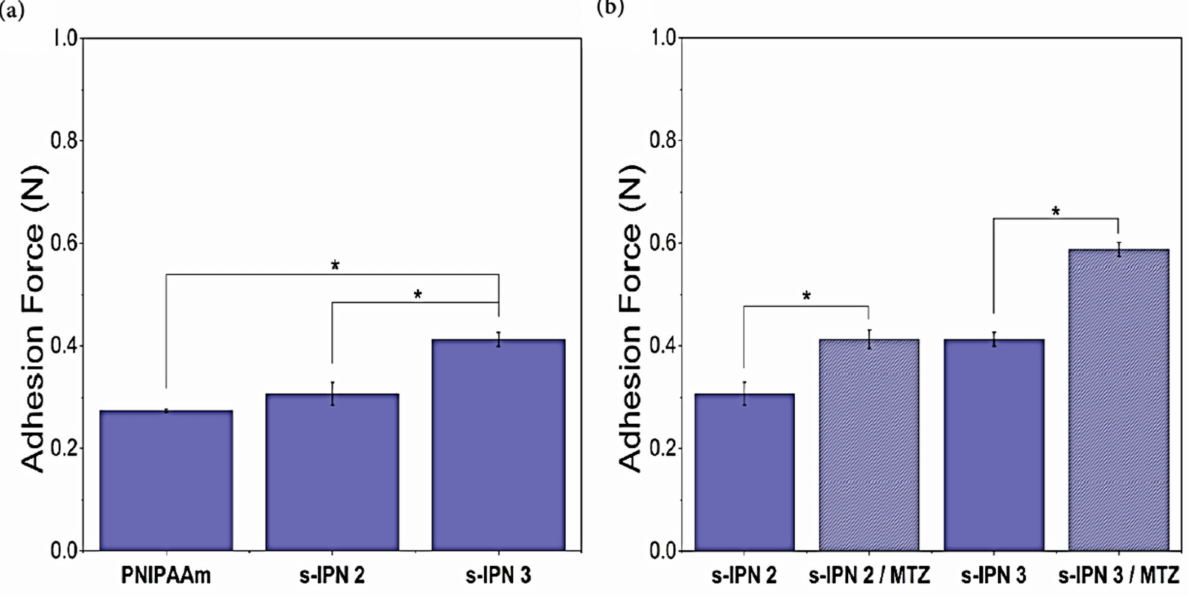
Figure 8. Bioadhesive properties of PNIPAAm, s-IPN 2, and s-IPN 3 samples ( a ), and those of s-IPN 2, s-IPN 3 with and without MTZ ( b ). Data are shown as the mean ± SD from three independent replicates. Statistical significance (* p < 0.05) was determined by ANOVA with a Tukey post hoc